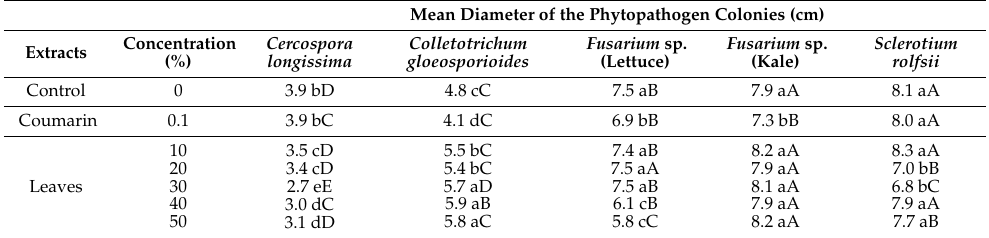
Table 4. Antifungal activity of the ethanolic extracts of D. odorata , in different concentrations. Mean Diameter of the Phytopathogen Colonies